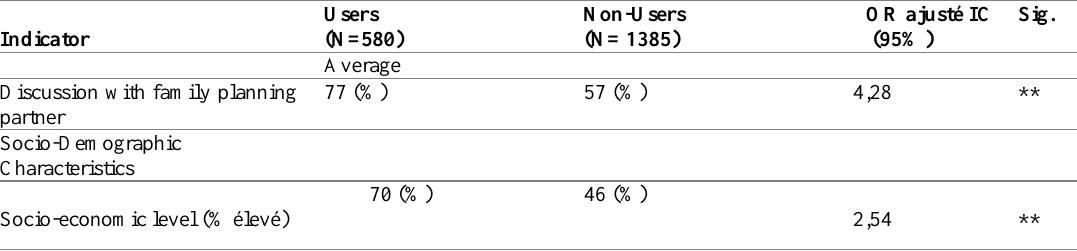
Non-Users (N= 1385)